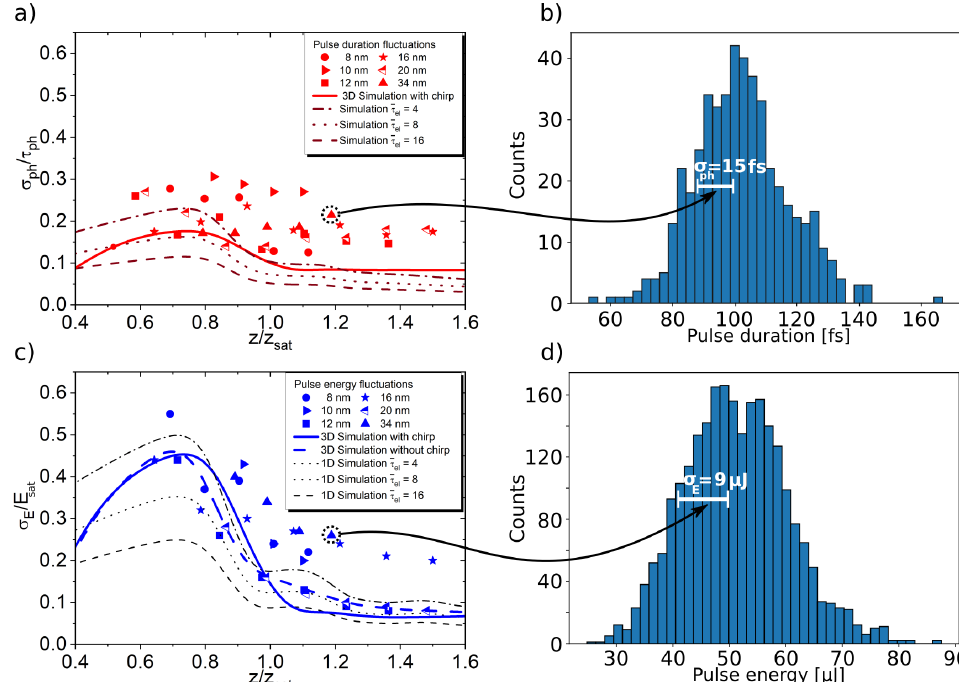
Figure 4. Shown are the fluctuations as functions of the undulator coordinate z for ( a ) the pulse duration and ( c ) the pulse energy. For each setting, several thousand FEL pulses were measured, leading to a broad, Gaussian distribution as shown in ( b ) the pulse duration and ( d ) the pulse energy. The example histograms in ( b , d ) are corresponding to the data point shown with the dashed circle. The values for the fluctuations shown are the rms values of the measured pulse energies and pulse durations which are equivalent to the 1/ e width of the histogram (for the nearly Gaussian distribution). In addition, the theoretically determined values for the fluctuations (only taking the SASE-induced effects into account) are plotted for the chirped and nonchirped 3D simulation and 1D simulation for the cases of ¯ τ el = 4, 8, and 16. The fact that the measured fluctuations are larger than the theoretically expected values (only for SASE) can be attributed to measurement uncertainty and additional technical fluctuations in the accelerator, as was discussed in Ref.